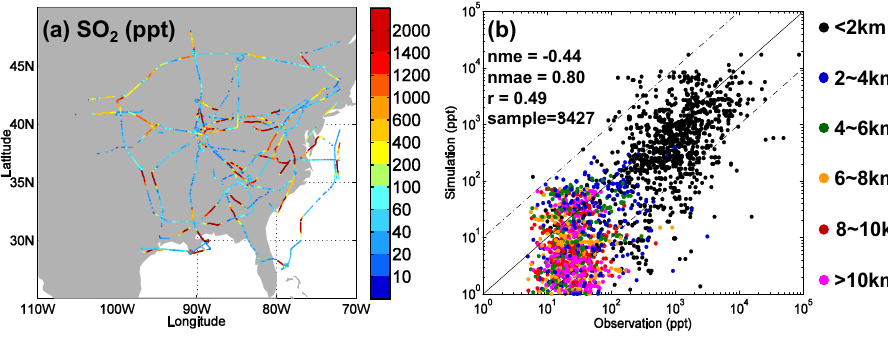
Fig. 2. Comparison of SO 2 simulated by WRF-Chem+APM and the aircraft observation obtained during INTEX-A: (a) observed SO 2 by aircraft, view from the top; (b) scatter diagram of the observed and simulated SO 2